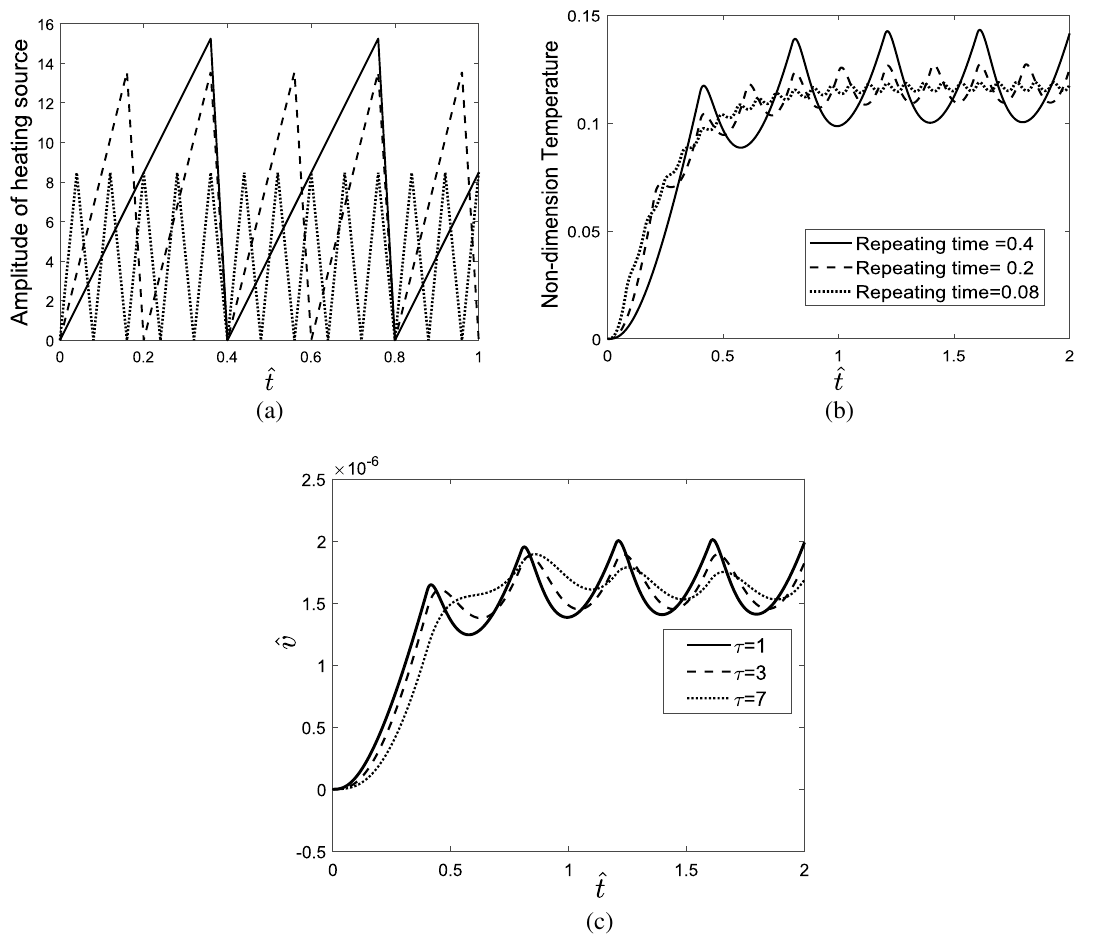
Figure 11. ( a ) Repetitive ramp heating source, ( b ) temperature response of the skin tissue considering different repeating times, ( c ) time-domain response of tissue along depth direction for different values of relaxation